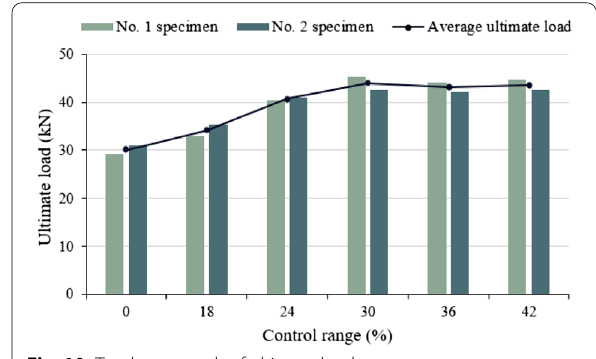
Fig. 10 Tendency graph of ultimate load